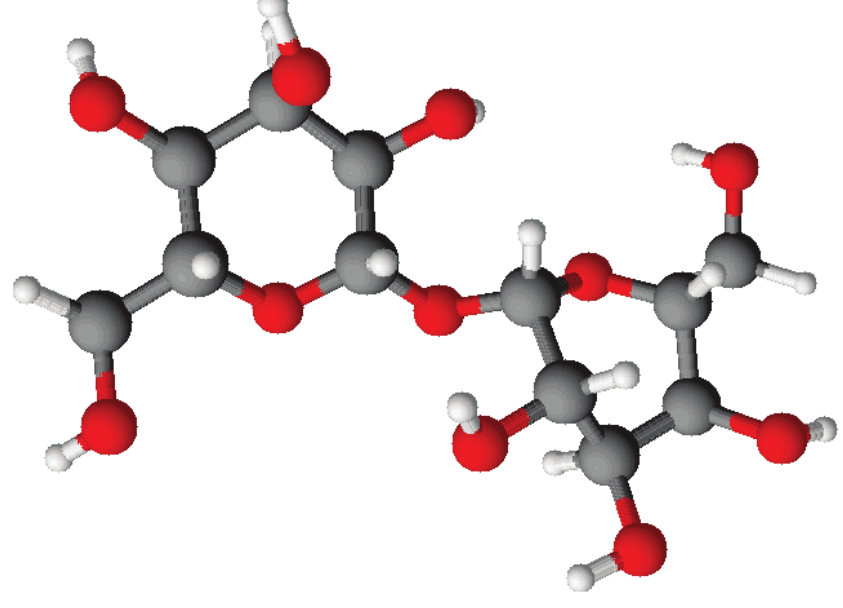
Figure 1. Chemical structure of